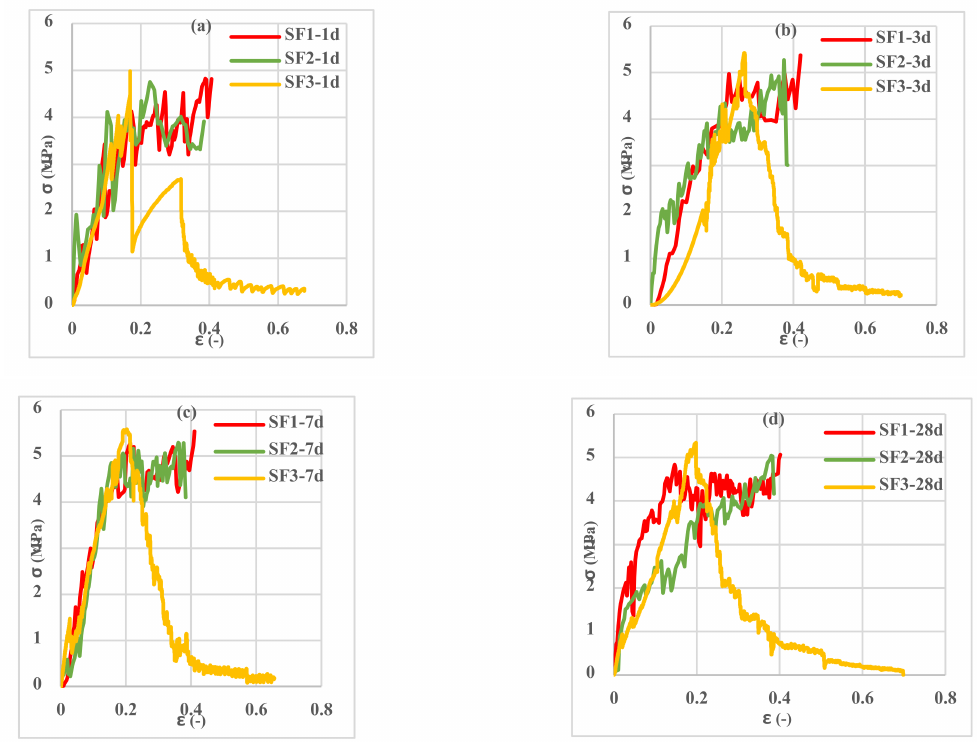
Figure 13. Tensile stress–strain curves of reinforced mortar with 3 types of spacer fabrics in the weft direction cured at 23 ◦ C